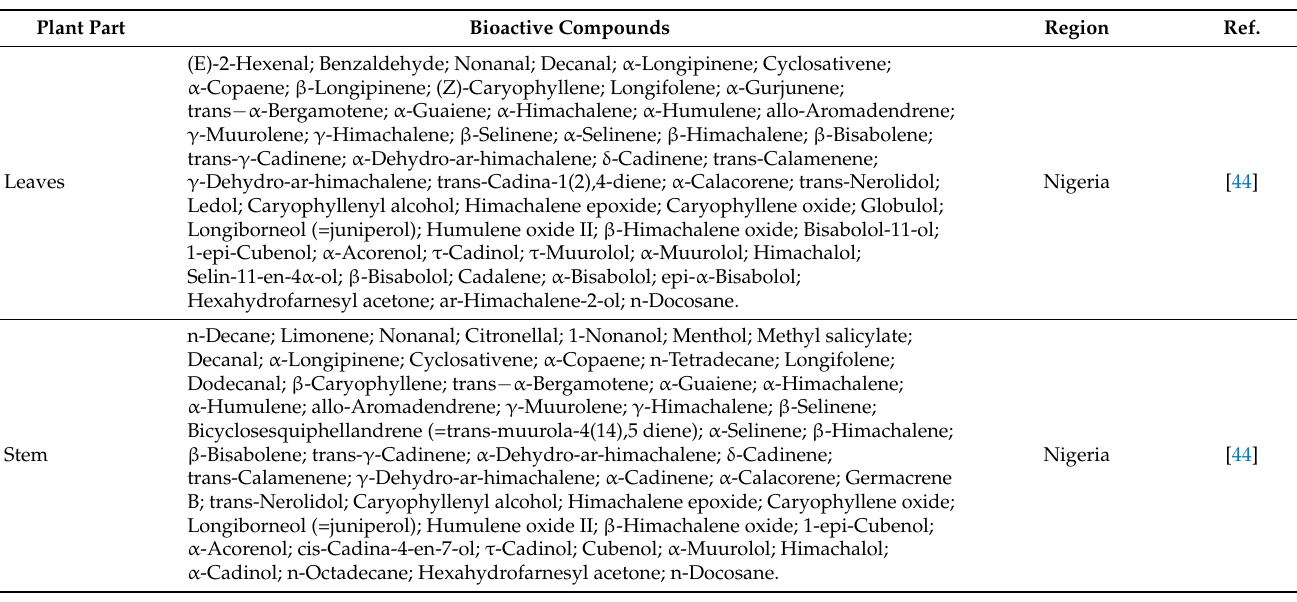
Table 7. Essential oil composition of Cajanus cajan